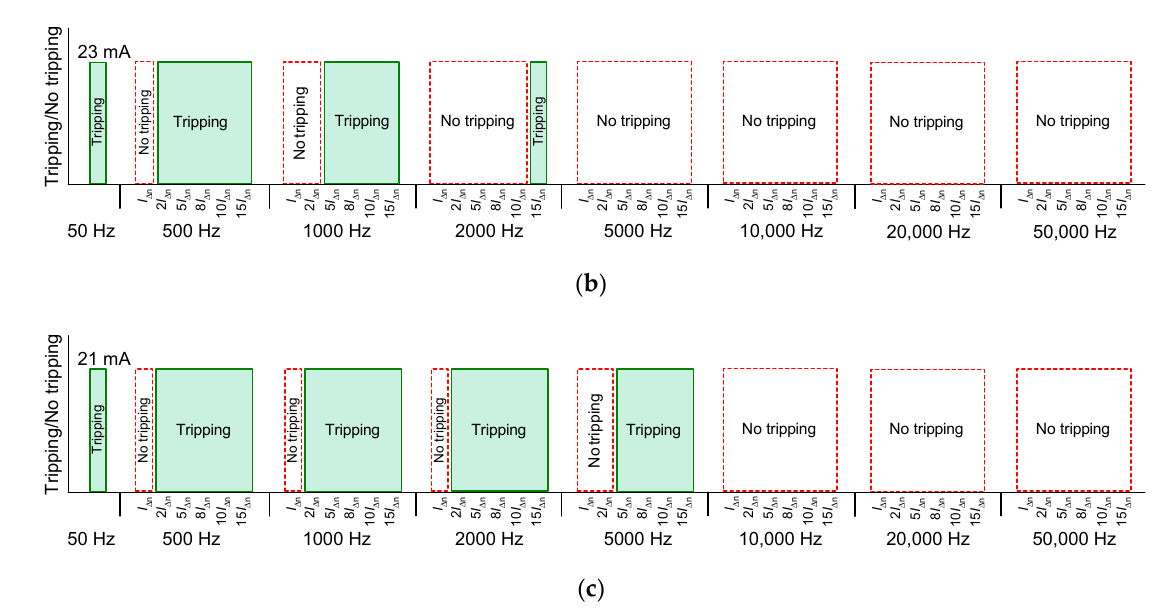
Figure 13. Tripping of the 30 mA AC-type RCDs for a sine waveform of the specified frequency from 50 Hz to 50 kHz: ( a )